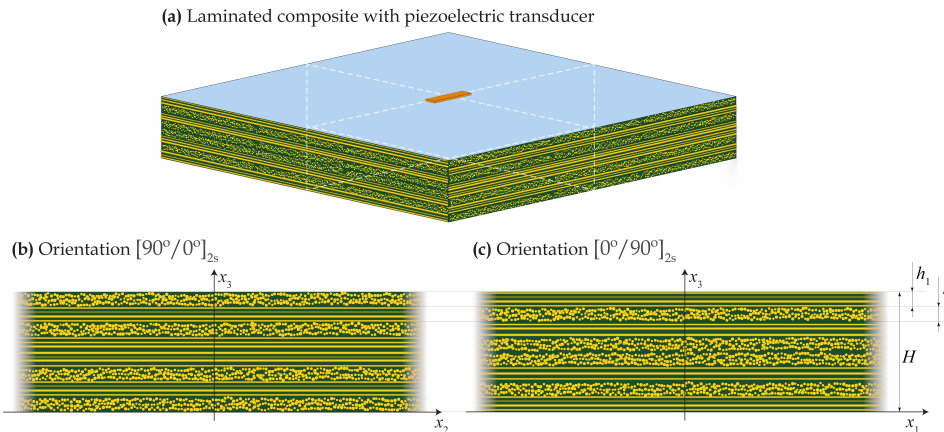
Figure 1. Multi-layered composite with a piezoelectric